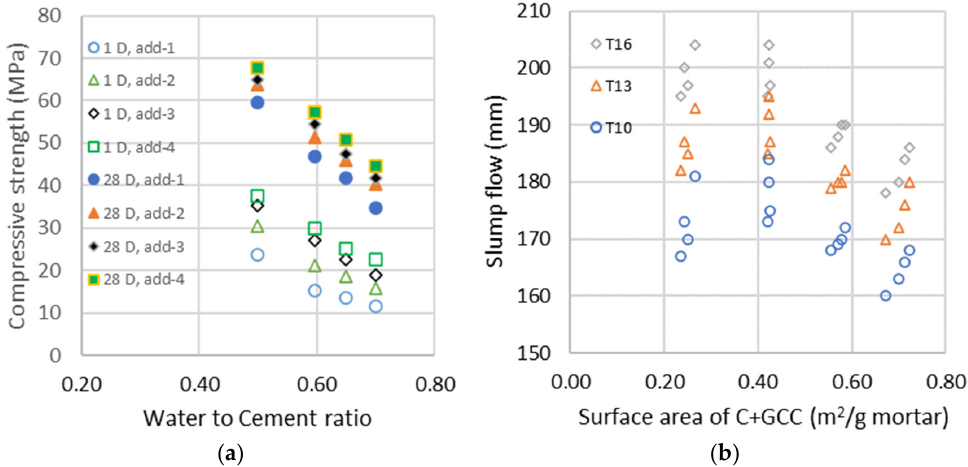
Figure 2. ( a ) Compressive strength of the different additions at days 1 and 28 as a function of the water-to-cement ratio; ( b ) Evolution of the slump flows measured with the shock table after 10, 13 and 16 shocks as a function of the surface area of cement and GCC (C+GCC). The acceleration of fine GCC in hydrates’ formation is quantified with factor 𝑙(𝑡) , which is a function of the ratio between the clinker and GCC concentration, as shown in Equation (6):